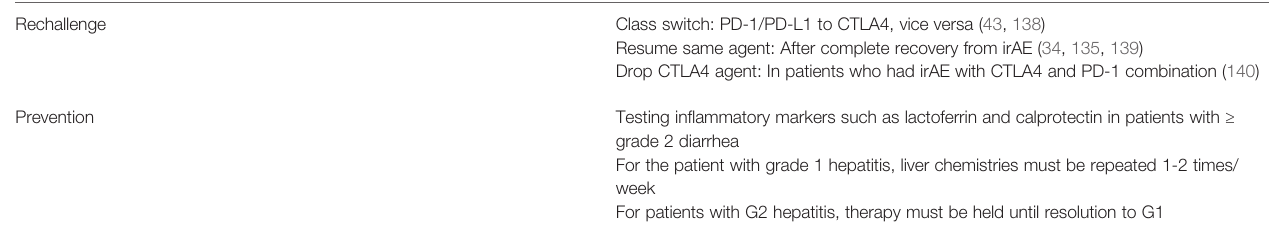
TABLE 3 | Rechallenging immune-checkpoint inhibitors and prevention of immune-related adverse events.